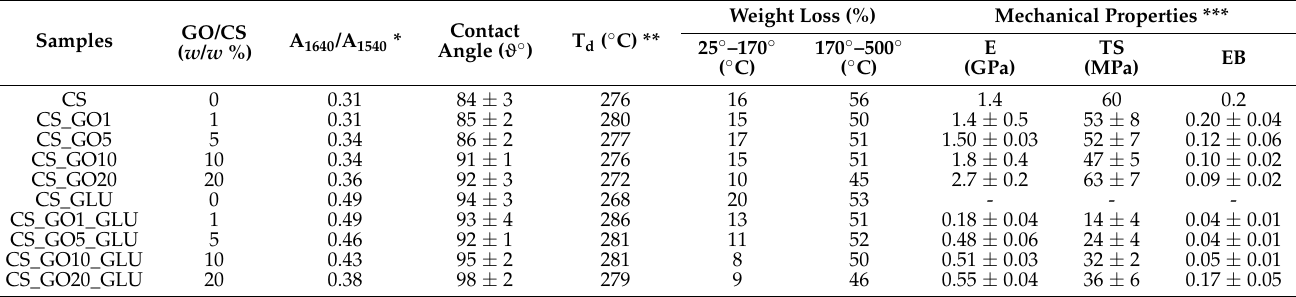
Table 1. Physical properties of the CS_GO and CS_GO_GLU